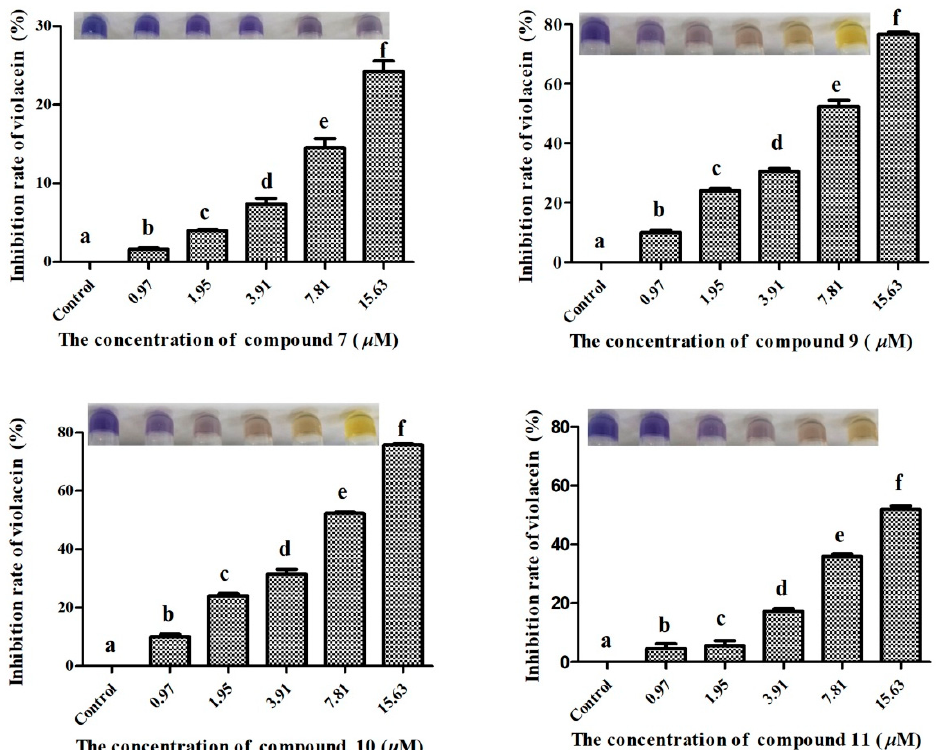
Figure 5. Inhibitory effects of compounds 7 , 9 , 10 and 11 on purple pigment formation of C. violaceum ATCC 12472. Note: The images shown are presented as the means ± standard deviation from three independent experiments in triplicates. The same letter indicates that the difference is not significant, and the different letters indicate significant differences.